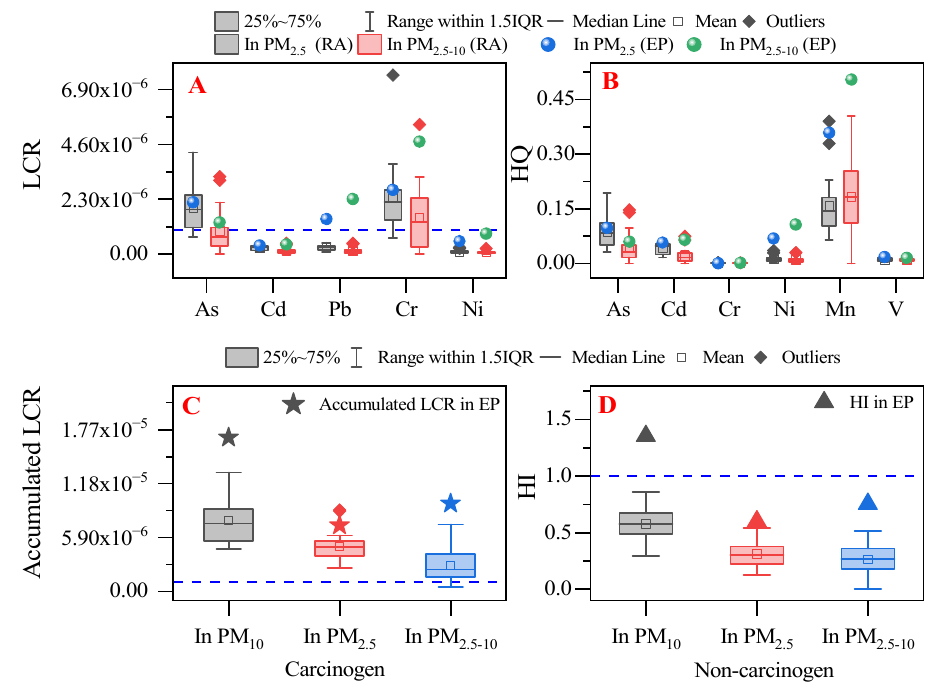
Figure 4. Life cancer risks (LCR) of single metal ( A ), hazards quotient (HQ) of single metal ( B ), the accumulated LCR of five metals ( C ), and hazards index (HI or accumulated HQ) of six metals ( D ) in PM 2.5 and PM 2.5–10 . EP: e-waste dismantling park; RA: the surrounding residential areas; the blue dash lines: the safe threshold of LCR and